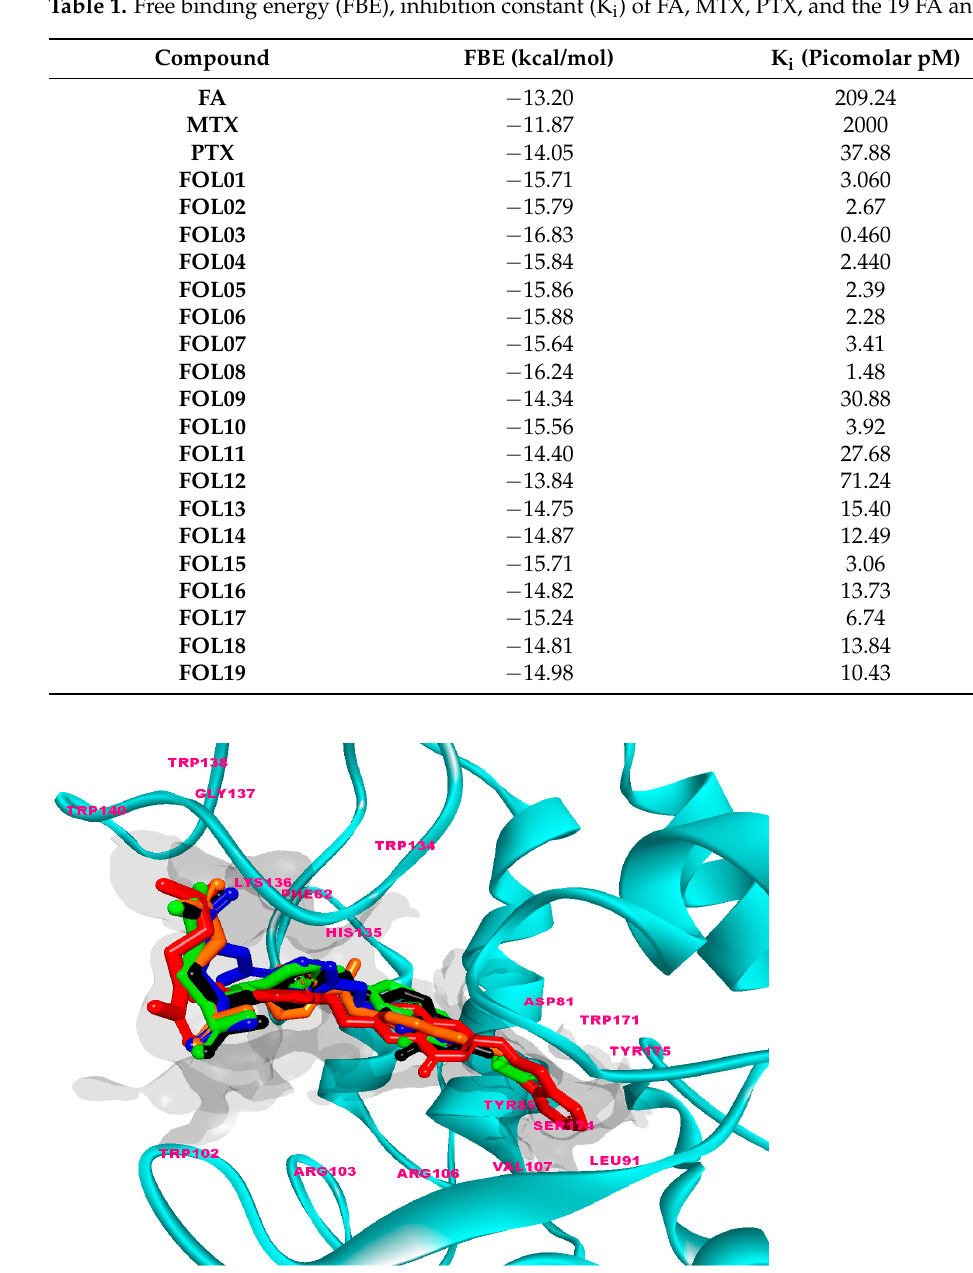
Figure 4. Superposition of FA (black), MTX (orange), PTX (blue), FOL03 (green), and FOL08 (red). Polar amino acids such as ASP81, LYS136, ARG103, HIS135, and non-polar amino acids such as TRP138, TRP140, and GLY137 played significant roles in stabilizing the FA– FR α complex, via H-bonding with the pteridine and the glutamic acid moieties (Figure S3). ASP81 is a dicarboxylic mono-amino acid and it is located at ~10 Å in the depth of the FR α pocket, as described earlier in Figure 3a. It forms two strong intermolecular H-bonds with FA; one with a pteridine ring at N4 at a distance of 1.67 Å and the other with the primary amino group N6 at a distance of 2.14 Å (Figure S3). This observation is consistent with previous studies that showed ASP81 interacted with the pteridine ring and is con- sidered as a key contributor to high folate affinity [22,65]. In addition, two H-bonds were also formed between the carbonyl group at the C10 position in FA with HIS135 (1.92 Å) and ARG103 (2.21 Å). HIS135, which is located 5 Å from the surface to the middle of the FR α pocket was also observed to form paired H-bonds with the glutamic acid moiety of FA at N7 (1.83 Å) and O6 (1.87 Å). The second carboxylic acid group from the glutamic acid moiety formed H-bonds with the non-polar amino acids TRP138 (2.50 Å) and TRP140 (2.05 Å). A non-covalent salt bridge interaction (ionic and H-bonds) was found to form be- tween the cationic ammonium in LYS136 with the carboxylate ion (O5 and O6) of the glu- tamic acid moiety with a bond length of 2.53 Å and 2.02 Å, respectively. This type of in- teraction commonly occurs between LYS and GLU in a protein and considered the most energetic non-covalent interaction that can be formed between any two functional groups [66]. An analysis of the 2D and 3D diagrams also showed the formation of a strong inter- molecular H-bond (1.93 Å) between the non-polar GLY137 with O4 from the glutamic acid moiety. This analysis confirmed the participation of FA in multiple intermolecular H- bonds with FR α . The interactions can be seen with ASP81 in the depth of the pocket, ARG103 and HIS135 in the middle, and LYS136, TRP138, TRP140, and GLY137 at the en- trance of the binding pocket. These H-bonds, coupled with the hydrophobic interactions, contributed to the high stability of the binding. This result is indeed in agreement with Chen et al. who reported FA recognition by FR α [22]. Interestingly, MTX has a lower affinity toward FR α as compared to FA. The substi- tution of the carbonyl by an amino in the pteridine moiety reduces the binding affinity. Figure S4 illustrated the important bonds between MTX and FR α and their respective lengths. The fundamental difference between MTX and FA lies in the bending of the MTX scaffold in the FR α pocket. The bending of MTX causes it to lose two hydrogen bonds with ARG103 and HIS135, leading to a lower binding affinity as compared to FA.